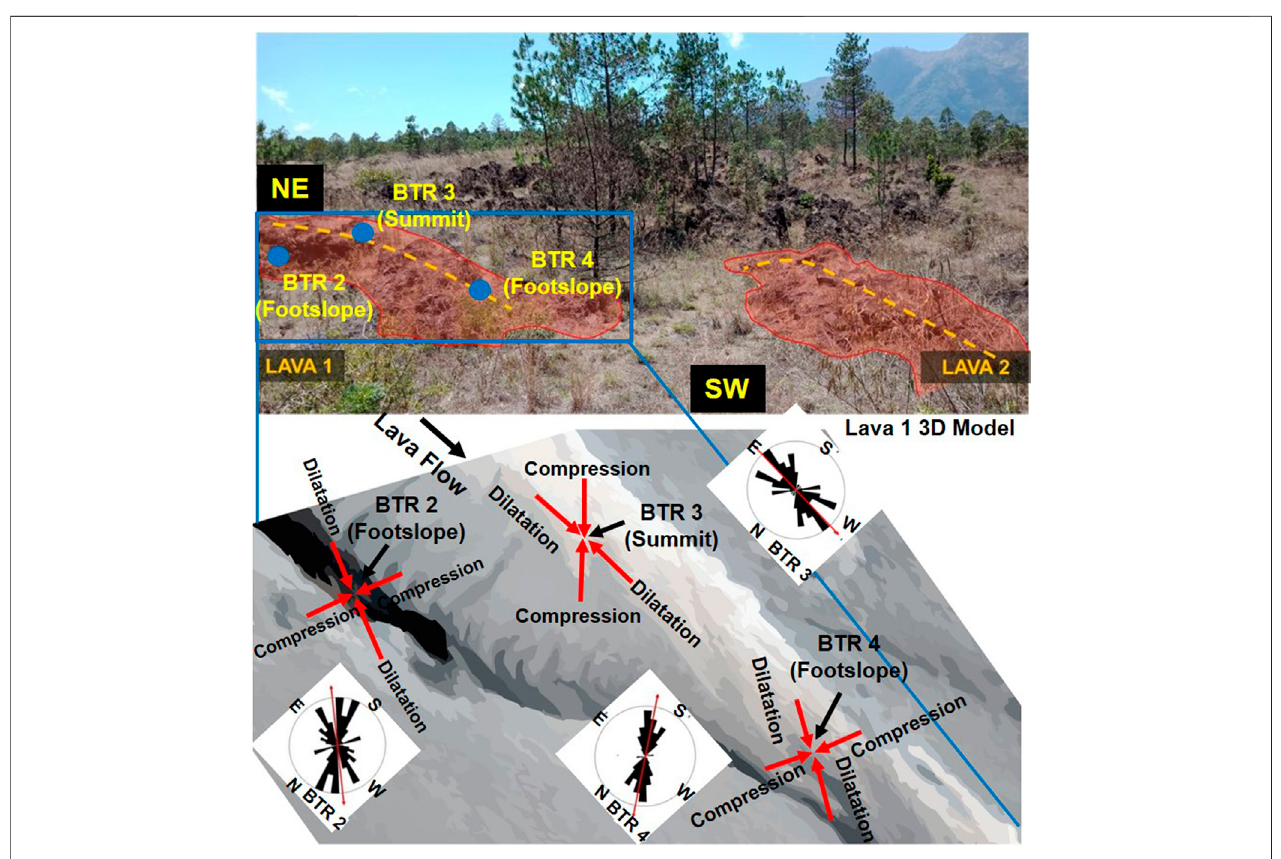
FIGURE 8 | Sample location and 3D model lavain Batur Volcano area with pore orientation rose diagram for BTR2, BTR3, and BTR4 sample. Reddish area is lava fl ow which the samples were obtained. Yellow dashed lines indicate the summit of lava fl ows. Red arrows indicate the compression and dilatation axes at the sampling